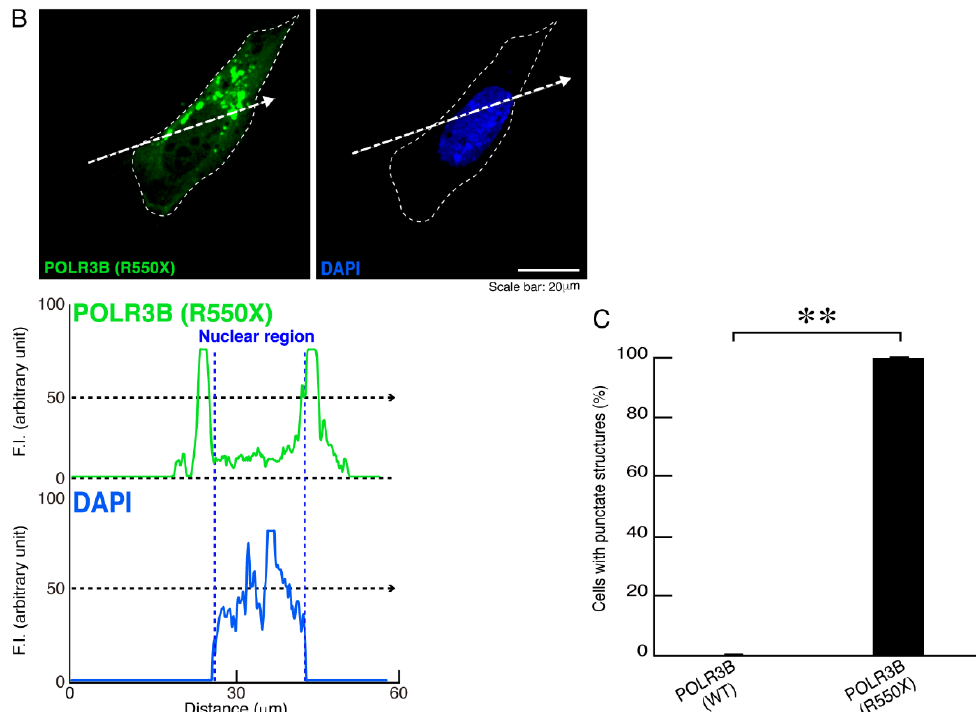
Figure 1. R550X mutant proteins of POLR3B accumulate in punctate structures in FBD-102b cells, whereas the wild type proteins are expressed throughout the cell body. ( A , B ) FBD-102b cells, sur- rounded by dotted lines, were transfected with the plasmid encoding the wild type (WT) POLR3B or the R550X mutant constructs. Transfected cells were detected using transfected proteins (green) and nuclear DAPI (blue). Scan plots were performed along the white dotted lines in the direction of the arrows in images. Graphs showing the fluorescence intensities (arbitrary units) along the white dotted lines in the direction of the arrows can be seen in the bottom panels. ( C ) Percentages of cells with punctate structures were statistically assessed (** p < 0.01; n = 3